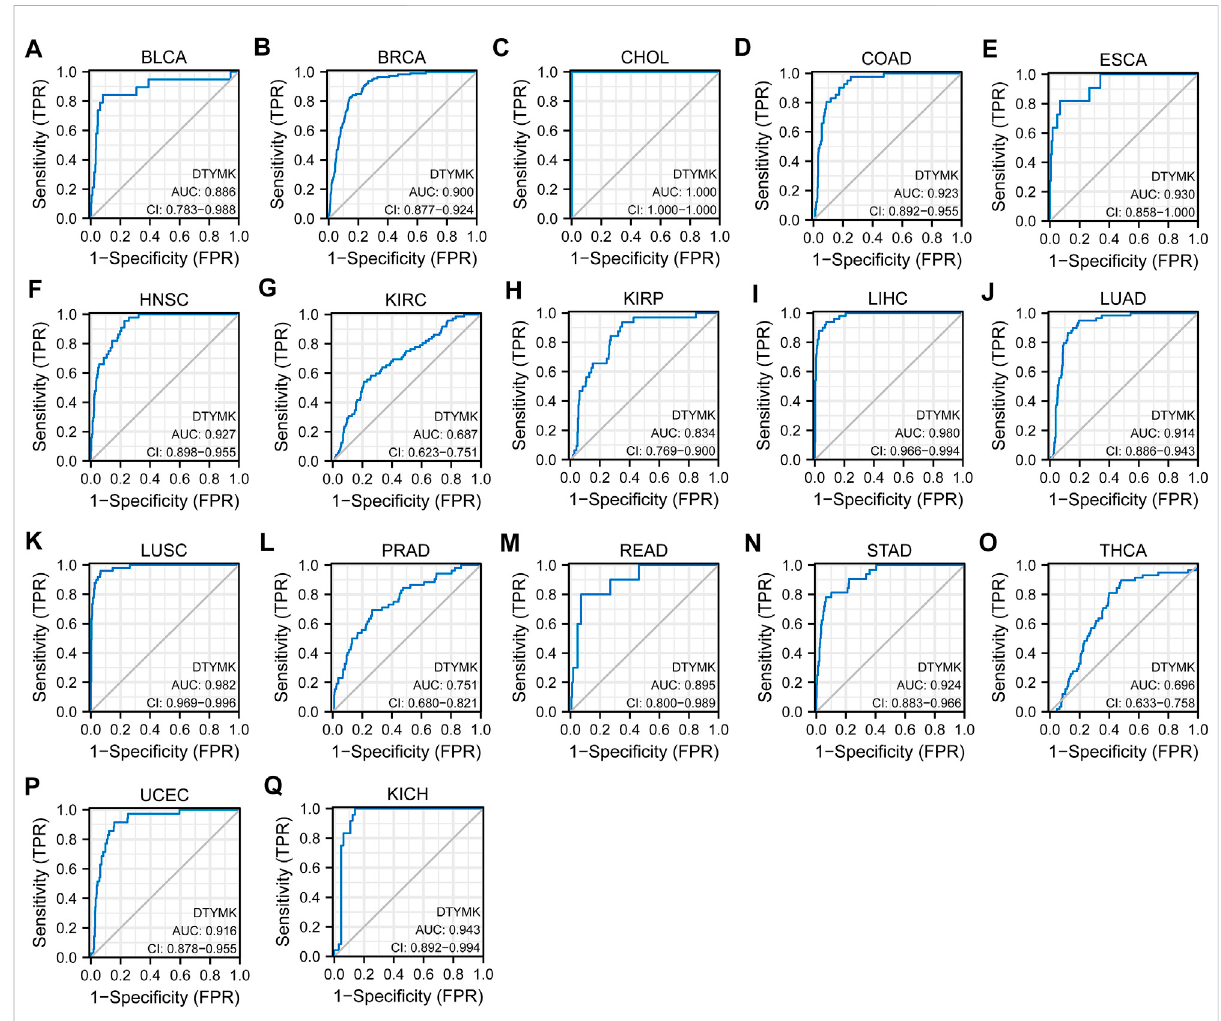
FIGURE 4 DiagnosticvalueofDTYMKtodistinguishtumortissuesfromnormaltissues.TheAUCvaluewasmorethan0.8in (A) BLCA, (B) BRCA, (C)